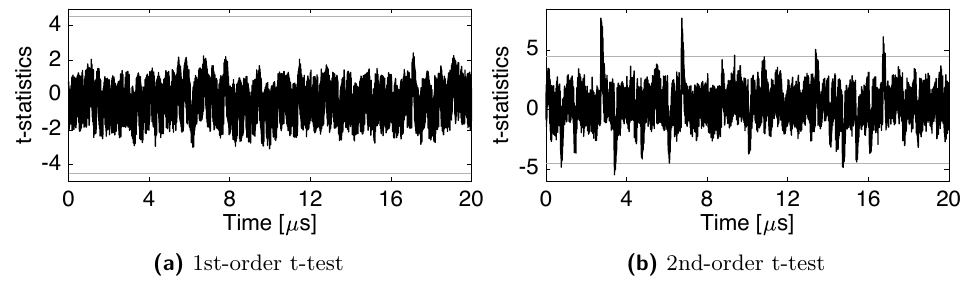
Figure 11: Experimental analysis of our masked Skinny while only PRNG is off using 100 million traces, confirming the ability of our setup to detect 2nd-order